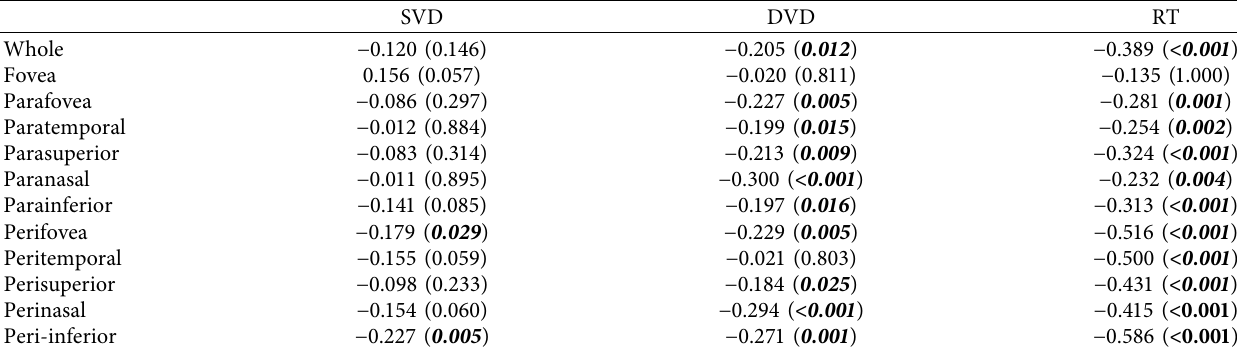
Table 4: Correlation between AL and VD of superficial and deep and